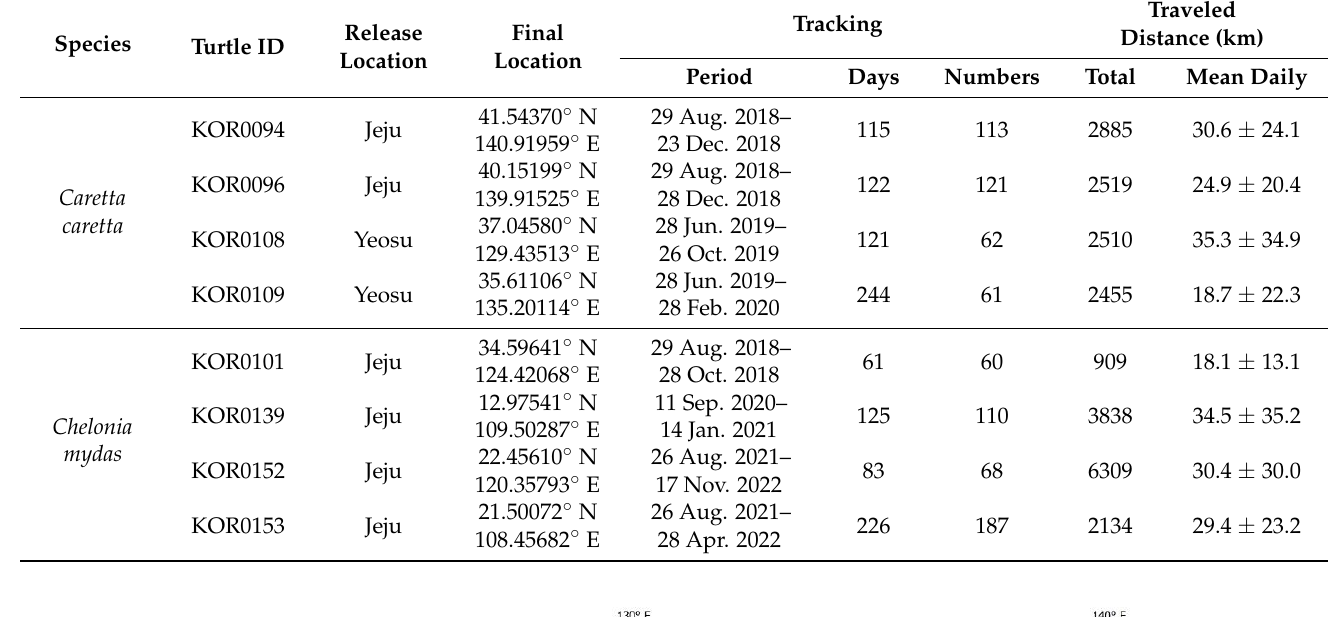
Table 2. Summary of the satellite-tracking of Caretta caretta and Chelonia mydas .